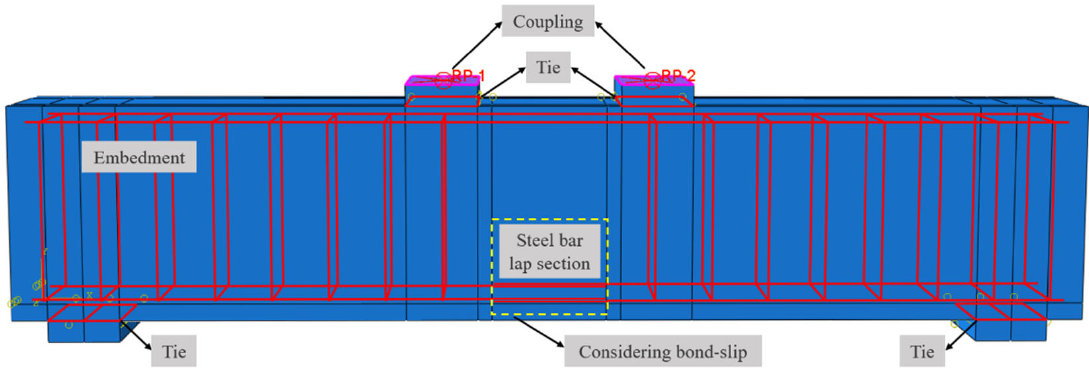
Figure 9. Finite element model interactions.